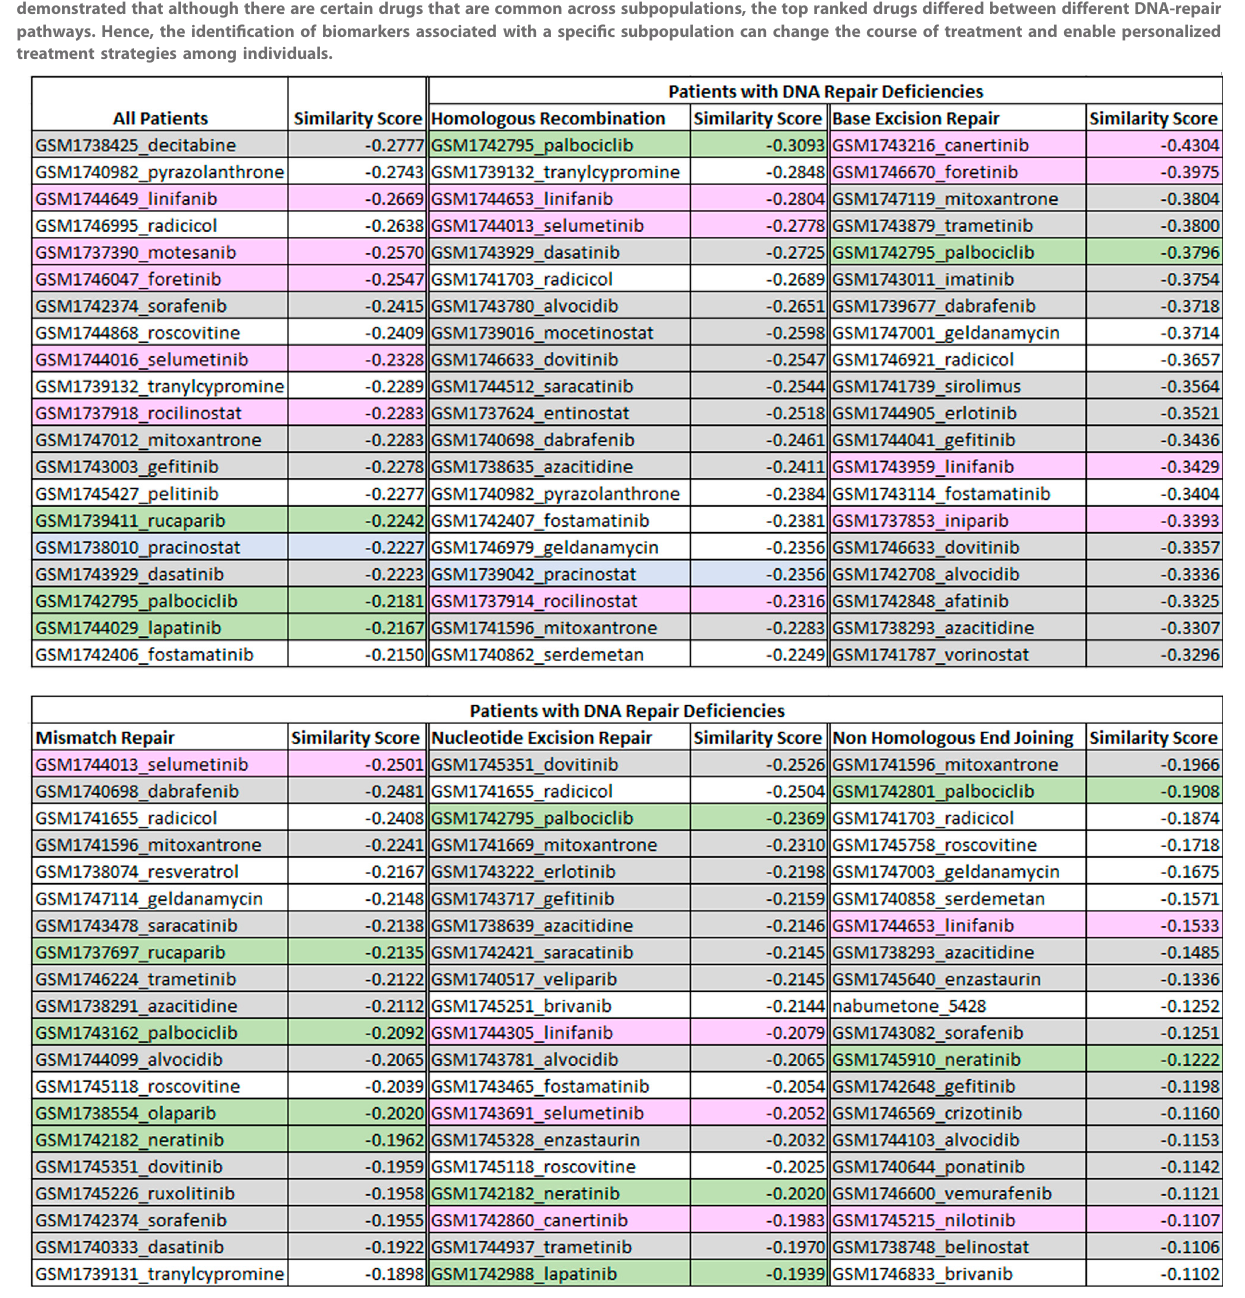
TABLE 2The listof topranked drugsidenti fi edthrough the drug-disease scoreanalysis forsubsets ofpatientswithdifferenttypes ofDNA repair de fi ciencies. The cells highlighted in green, grey, blue and pink are the FDA-approved drugs, investigational drugs for breast and prostate cancers, investigational drugs for prostate cancer, and investigational drugs for breast cancer, respectively along with their respective similarity scores that was calculated. Results demonstrated that although there are certain drugs that are common across subpopulations, the top ranked drugs differed between different